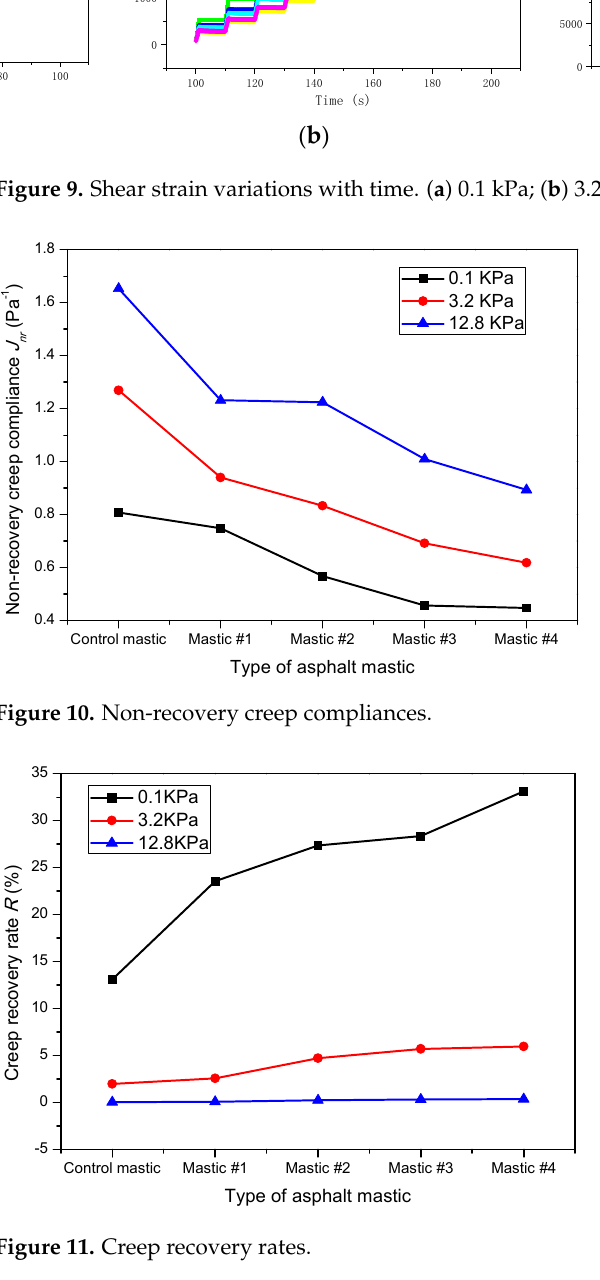
Figure 11. Creep recovery rates. Figure 10 shows that the non-recovery creep compliances of all the asphalt mastics increased with increasing applied stress levels, which was consistent with [44,45]. At the stress level 3.2 kPa, J nr of the control mastic was 1.28 kPa − 1 and satisfied the heavy (H) level of traffic loading according to AASHTO MP 19-10. Meanwhile, J nr of mastic #4 was 0.62 kPa − 1 and satisfied the very heavy (V) level of traffic loading. The comparison between J nr values highlights that HMF had a lower ability to increase J nr of asphalt than LMF. That is, HMF could better improve the deformation resistance of asphalt than LMF.